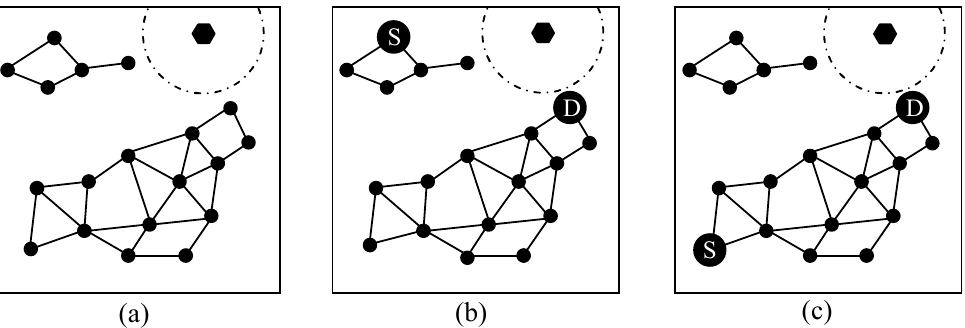
Figure 1. Different viewpoints on connectivity. (a): connectivity of whole network, (b) and (c): connectivity of two arbitrary